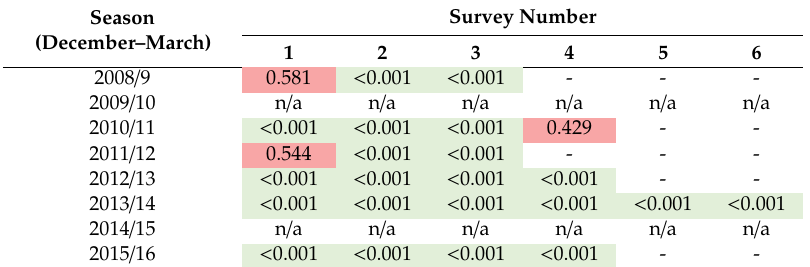
Table A2. Summary of p -values when comparing SF-WEPA and SF-Uninf shoreline forecasts. Green shading highlights p -values < 0.001, with pink shading for p -values ≥ 0.001.